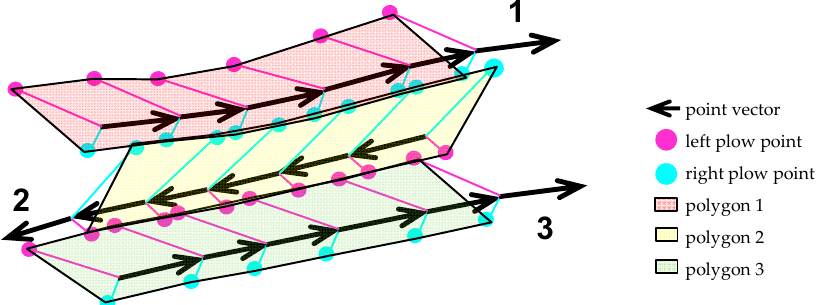
Figure 9. Schematic illustration of the modeling of the cultivated area for three exemplary